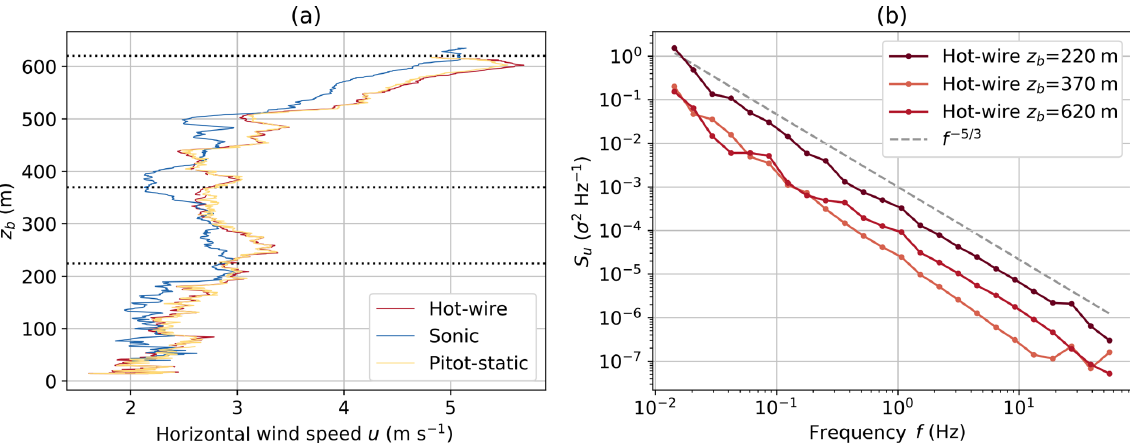
Figure 7. Horizontal wind velocity u measured on 8 June 2017 with UP and HP simultaneously. Panel (a) compares the vertical profile of wind velocity for measurements with the sonic anemometer, hot-wire anemometer and the pitot-static probe. The HP was attached 25m below the UP. Panel (b) contrasts power spectral densities for horizontal wind velocity S u measured with the hot-wire anemometer on three constant altitude segments of ∼ 1000s length (dotted horizontal lines in panel a ). The data for the spectra were sampled during an ascent shortly before the descent profile of panel (a)